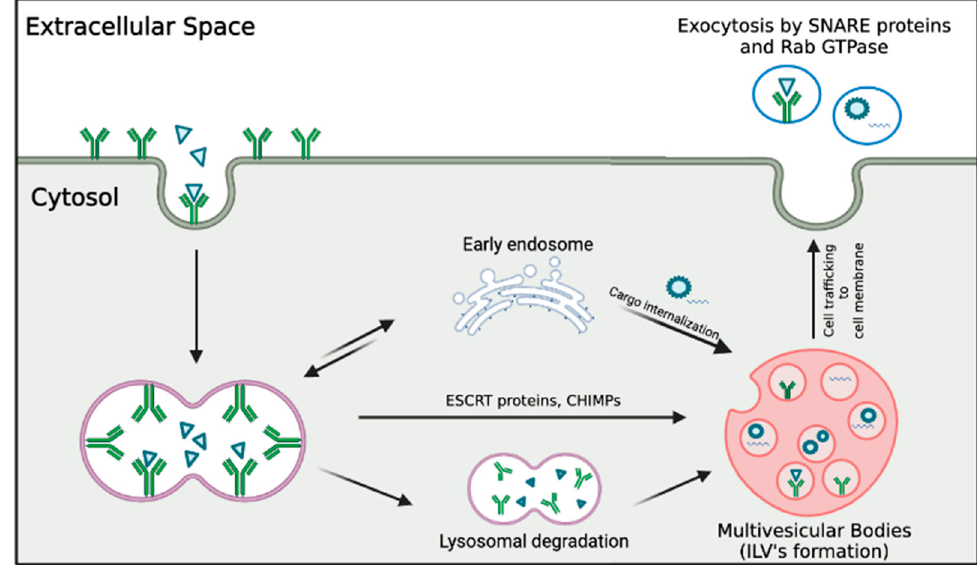
Figure 2. Features of exosome biogenesis. Exosome formation begins with the endocytosis of cell membrane components and lipids, initiating the formation of early endosomes in the cytosol. These endosomes undergo sorting by ESCRT and CHMP proteins, resulting in the formation of multivesicular bodies that house intraluminal vesicles. These multivesicular bodies are then tra ffi cked to the cell membrane, where the exocytic pathway releases exosomes into the extracellular space.